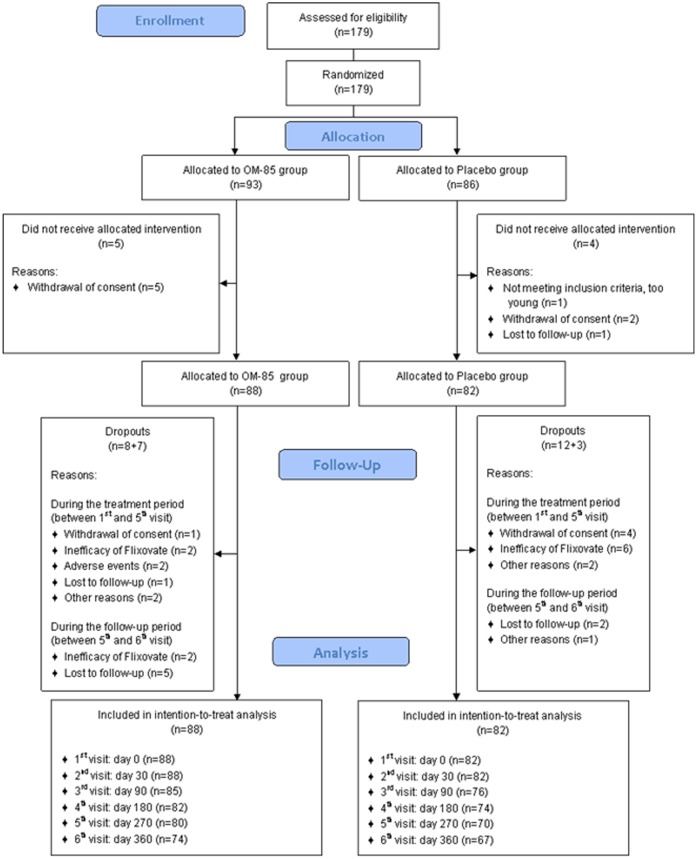
Study flowchart.